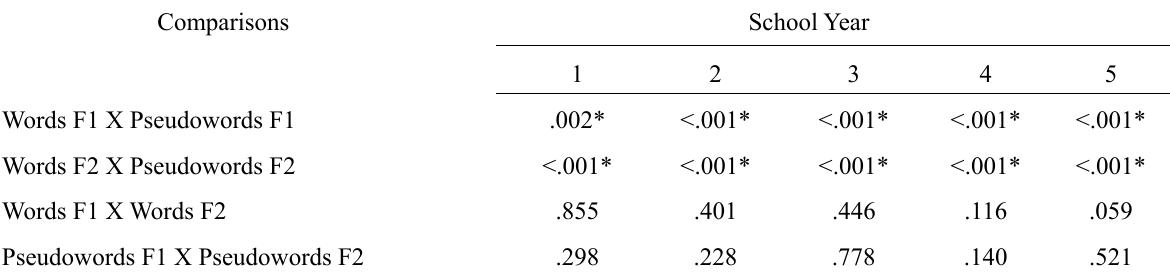
Signi fi cance (p-values) of Comparisons between Words and Pseudowords, Inter- and Intra-Version (forms 1 and 2)